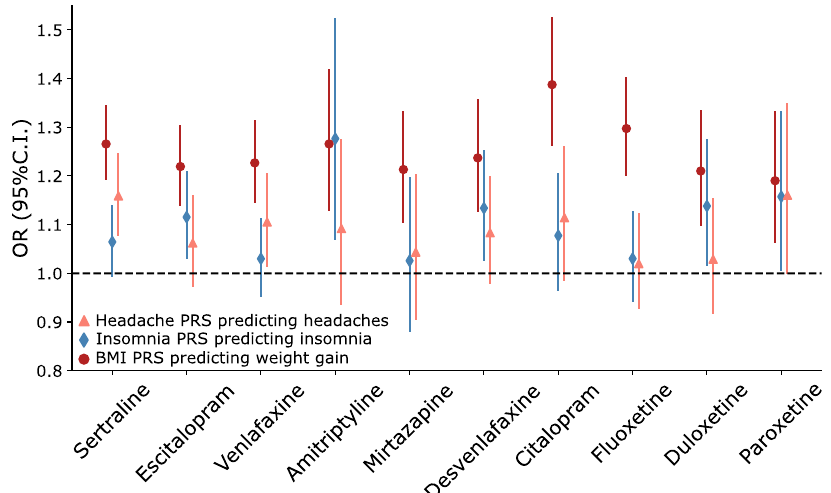
Fig. 4 Genetic prediction of antidepressant side effects. Forest plots show the results of associations between polygenic risk scores for BMI, insomnia and chronic headaches predicting weight gain, insomnia and headaches reported as side effects for antidepressant medications. Markers represent odds ratios (OR), and error bars represent 95% con fi dence intervals